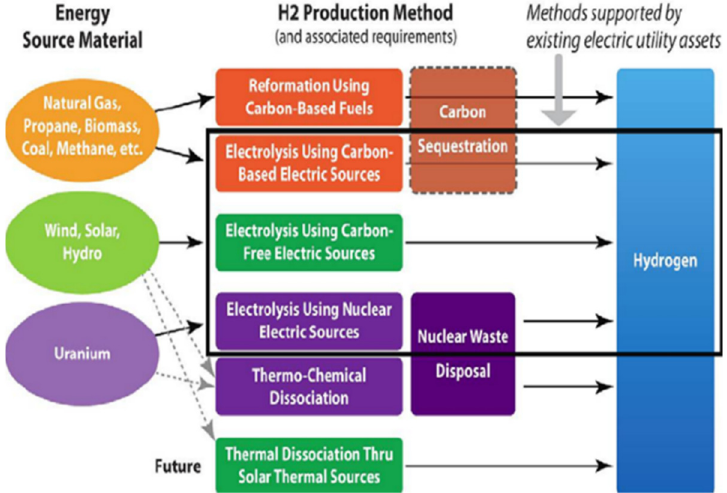
Figure 6. Diverse hydrogen production technologies and their energy sources. Reprinted with permission [35].